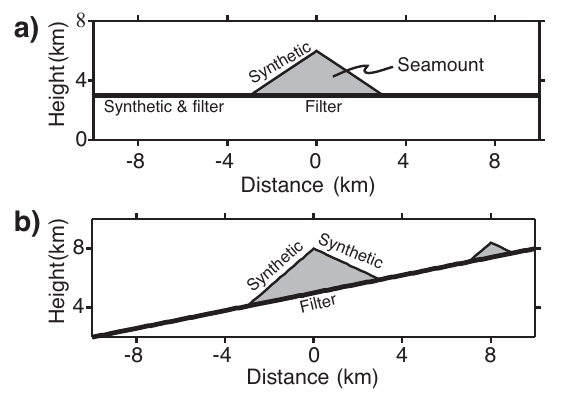
Figure 4. (a) A simple 2-D (i.e. distance–height profile) synthetic seamount (grey shading) (Hillier, 2008), which following Kim and Wessel (2008) is conical with a radius of 3km and summit height of 3km above the surrounding seafloor. The thin black line is the syn- thetic topography, and the thick black line the filter’s output. (b) A more demanding test of two variably sized seamounts upon a slop- ing